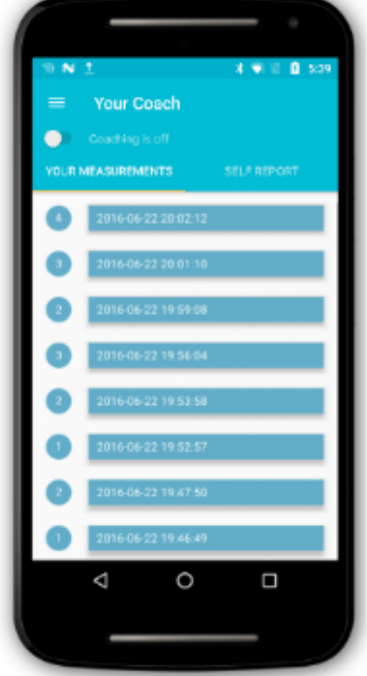
Figure 1. Sense-IT mobile phone graphical user interface, first version. The yellow switch starts and stops the measuring of heart rate (HR) via the smartwatch. Each recorded change in level of HR (or physiological correlate of emotional arousal [PCEA]) is represented a blue bar in the white area of the screen. The date and time of the change are displayed within the blue bar, and the level of the PCEA appears as a number in the circle left of the bar.